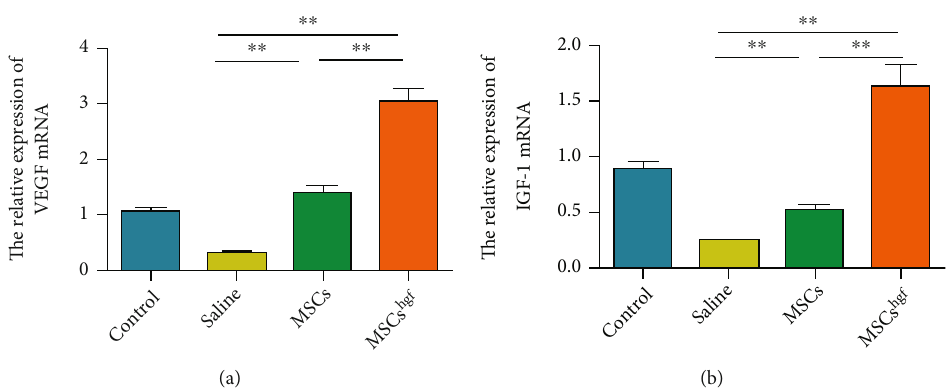
Figure 4: HGF gene-transfected MSCs promote the angiogenesis of damaged endometrium. (a) Relative expression of VEGF mRNA in each treatment group. (b) Relative expression of IGF-1 mRNA in each treatment group ( ∗∗ P < 0 : 01 , n = 3